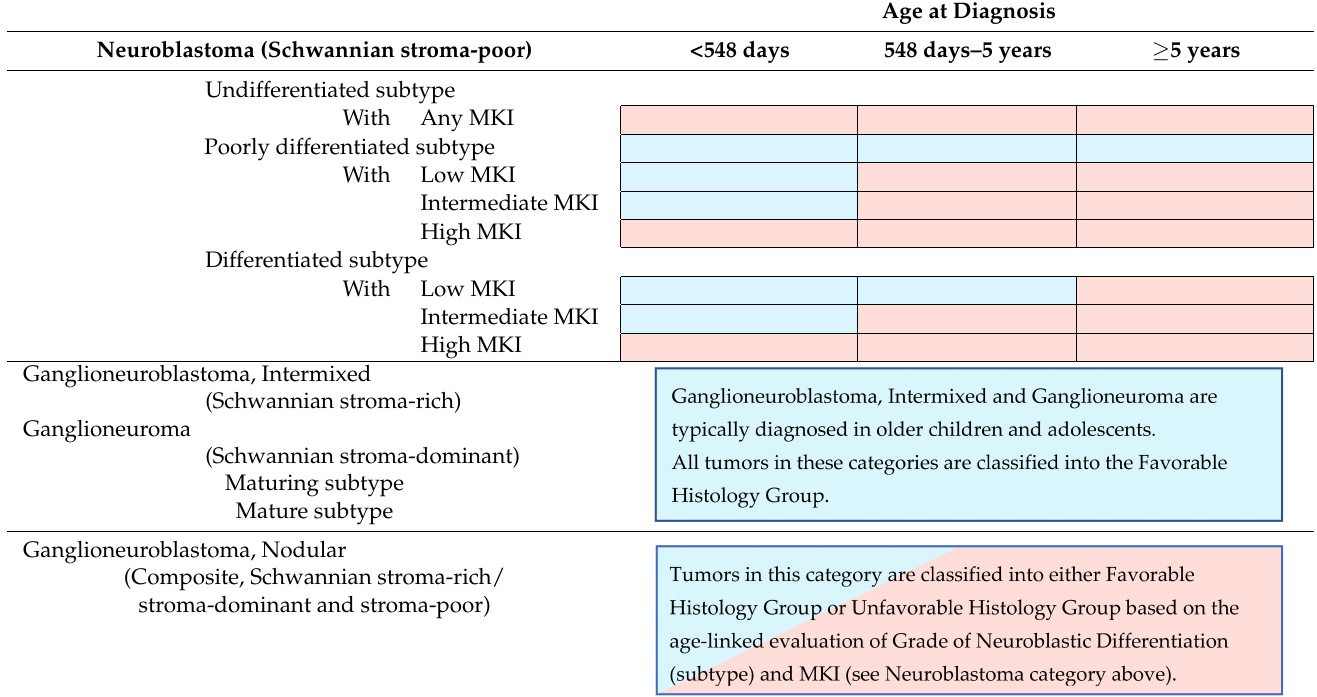
Table 1. International Neuroblastoma Pathology